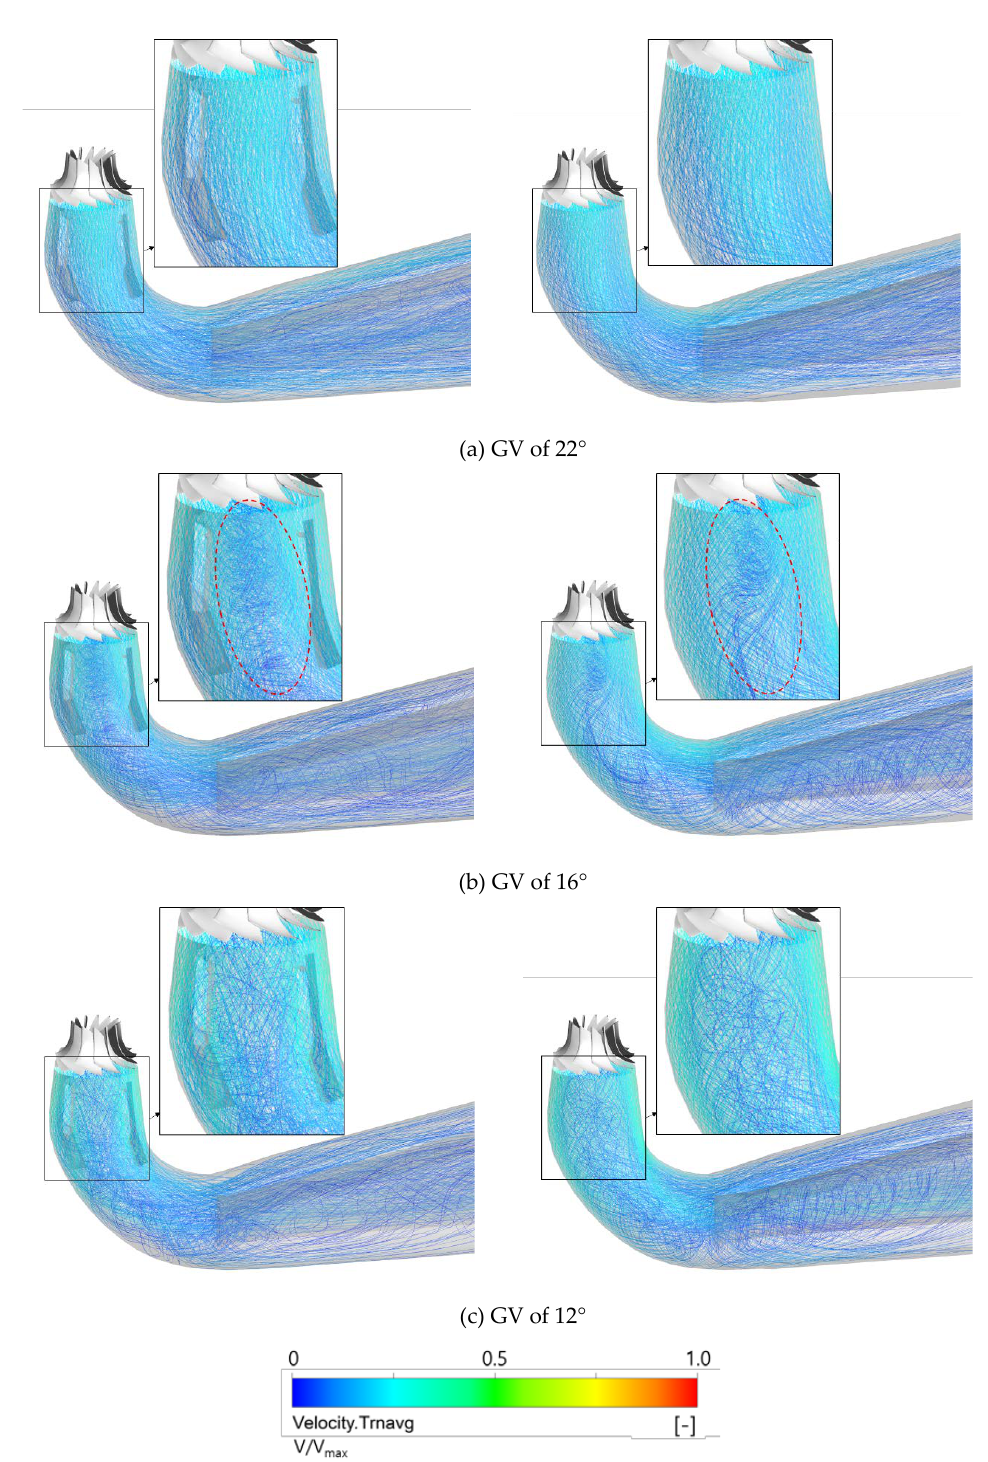
Figure 11. Streamline distributions in the DT (left column) with and (right column) without anti-cavity fins at GVs of (a) 22°, (b) 16°, and (c) 12°.